Question: Briefly state, in one sentence, what is plotted here.
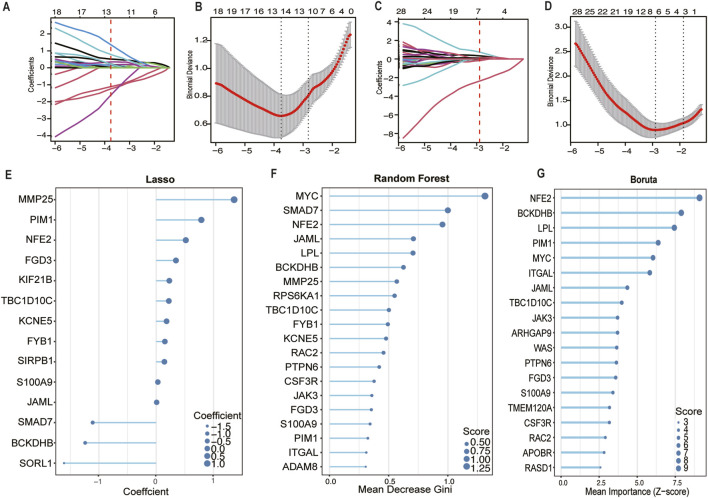
Answer: Screening of feature genes using LASSO, random forest, and Boruta algorithms. (A–D) LASSO regression feature selection and optimal parameter determination based on ten-fold cross-validation. (E–G) Core feature genes identified by LASSO, random forest, and Boruta algorithms, along with assessment of gene importance.